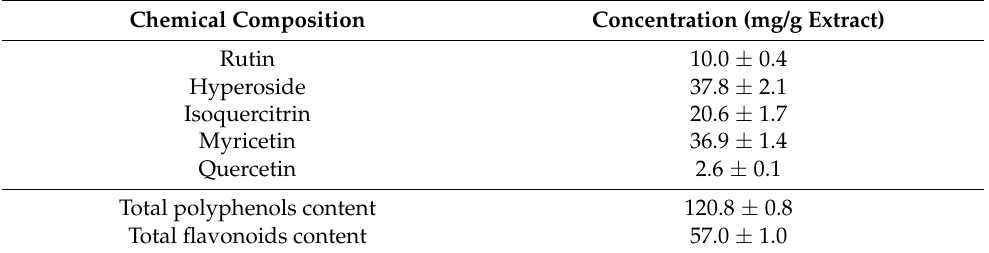
Table 1. Chemical compositions of